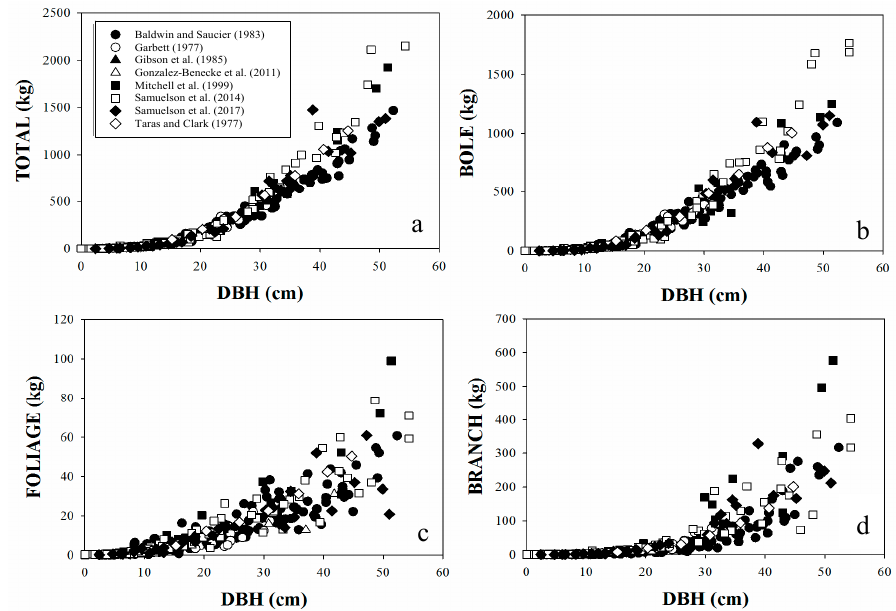
Figure 2. Relationship between DBH and ( a ) total tree above-stump biomass (TOTAL, kg); ( b ) bole biomass outside bark (BOLE, kg); ( c ) living foliage biomass (FOLIAGE, kg); and ( d ) living branch biomass outside bark (BRANCH, kg) for longleaf pine trees used in this study. Table 2. Summary statistics of tree and their associated stand characteristics for the sampled longleaf pine